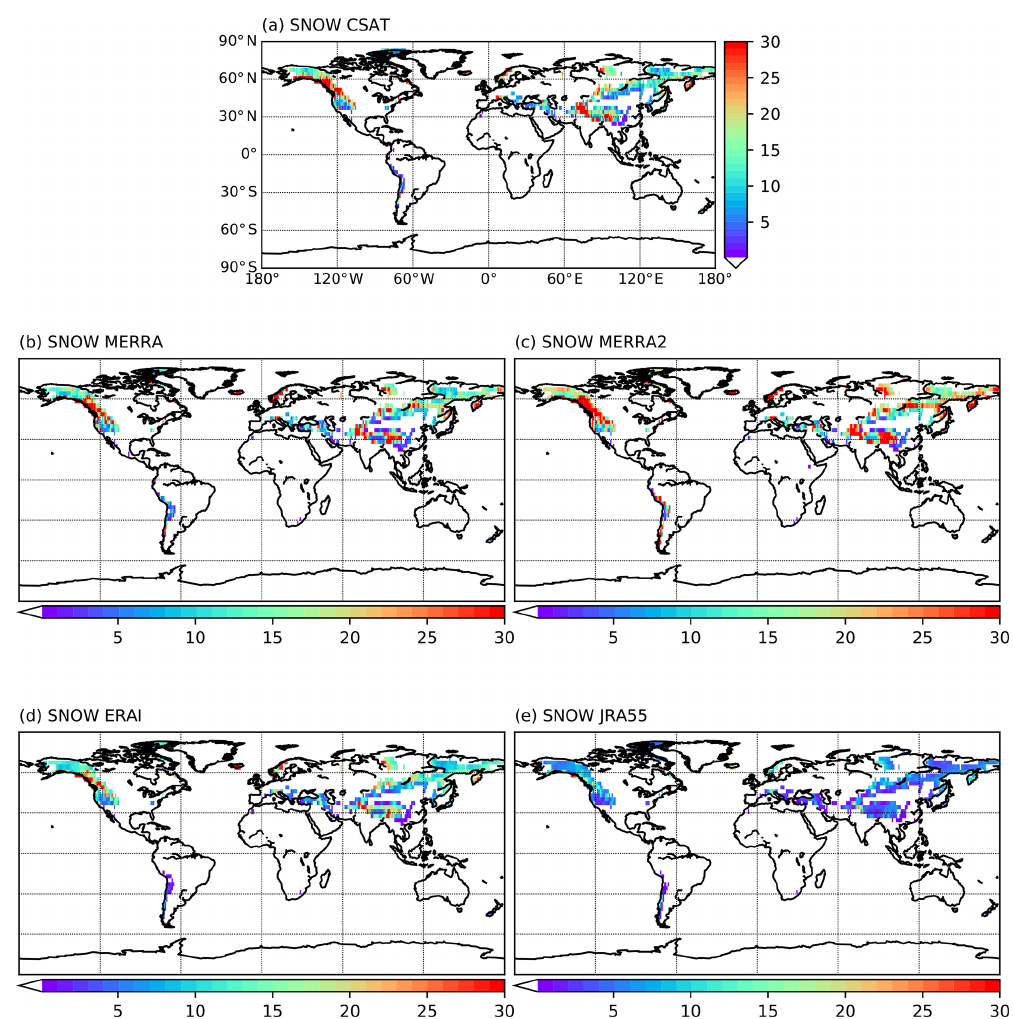
Figure 2. Spatial maps of global cumulative mountain snowfall (millimeters per month per grid box) for (a) CloudSat, (b) MERRA, (c) MERRA-2, (d) ERA-Interim and (e) JRA-55, averaged over the time period